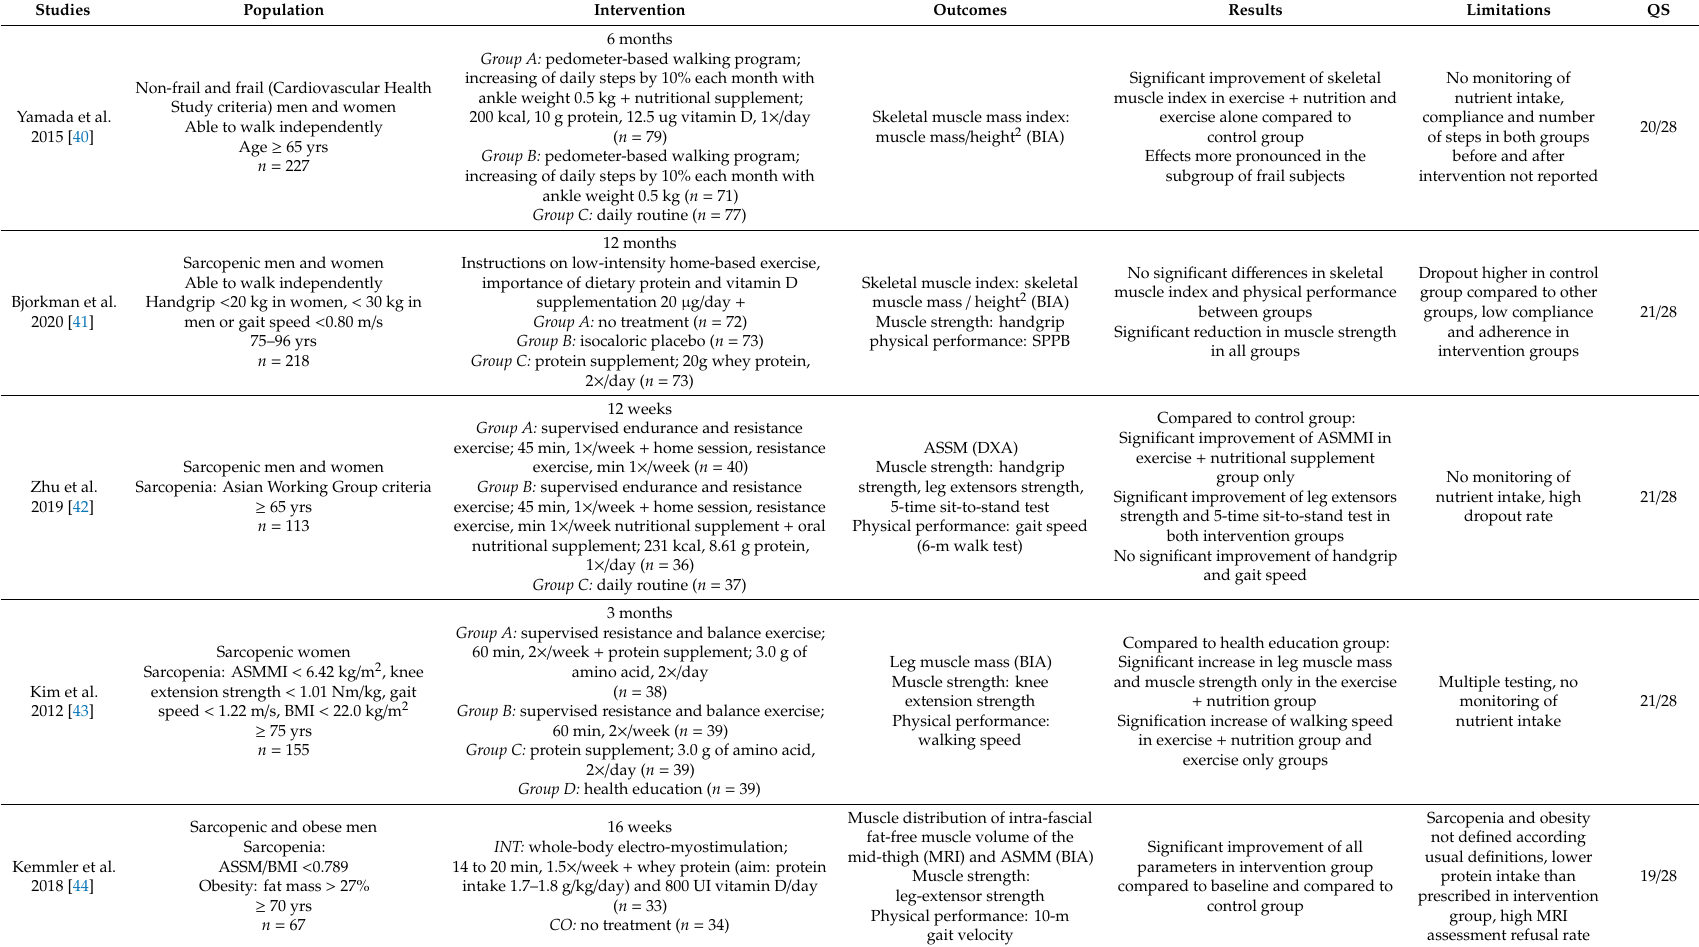
Leg muscle mass (BIA) Muscle strength: knee extension strength Physical performance: walking speed